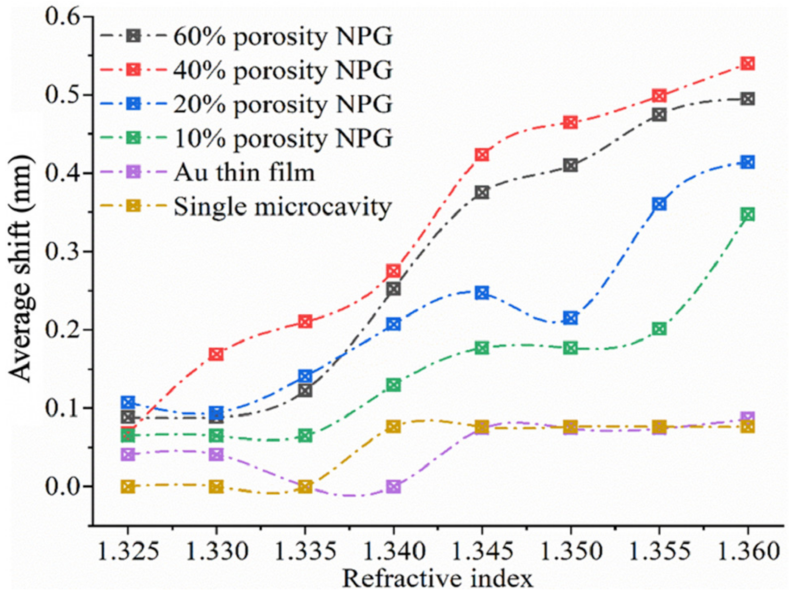
Figure 5. Simulation results of RI-sensing performance of microcavity-LSPR hybrid biosensors with different NPG